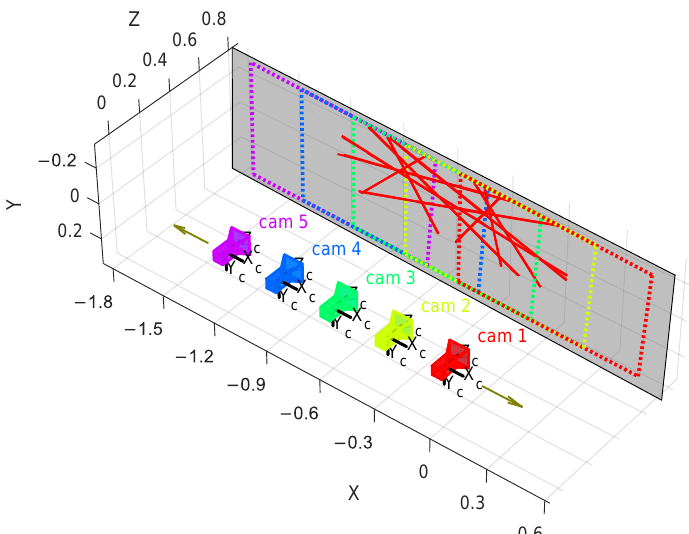
Figure 11. The five poses of the camera, the position of the plane, and the 10 projected lines. The respective fields of view are shown in a dashed line. The arrows show the direction of travel of the translation stage.